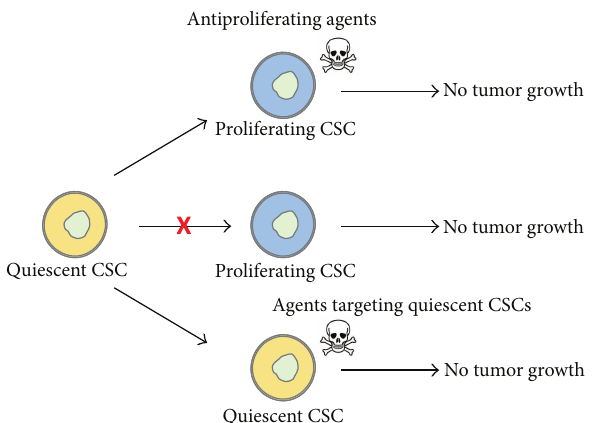
Figure 3: Strategies proposed for neutralization of the CSC quiescent phenotype involved in treatment resistance. Three strategies have been proposed to neutralize the quiescent CSC-state. Induction of CSC entry into the cell cycle would sensitize cells to antiproliferating agents. Blocking quiescent CSCs in G0 was proposed as an alternative for preventing new tumor growth. Targeting CSCs in the quiescent state was also proposed for the elimination of this particular CSC subpopulation. CSC: cancer stem cell. Figure was constructed in part with objects from Servier Medical Art documents under license from Creative Commons Attribution 3.0 France